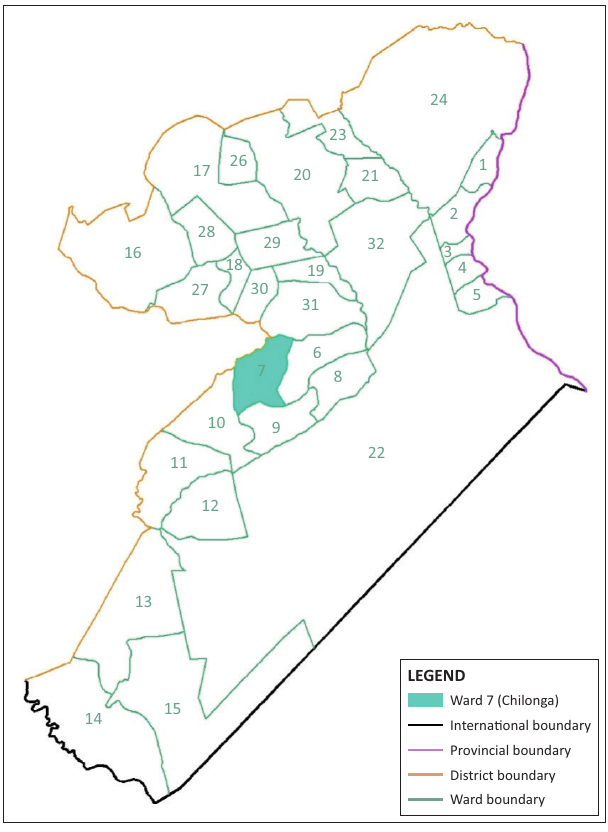
FIGURE 1: Map of Chiredzi showing location of Chilonga Ward